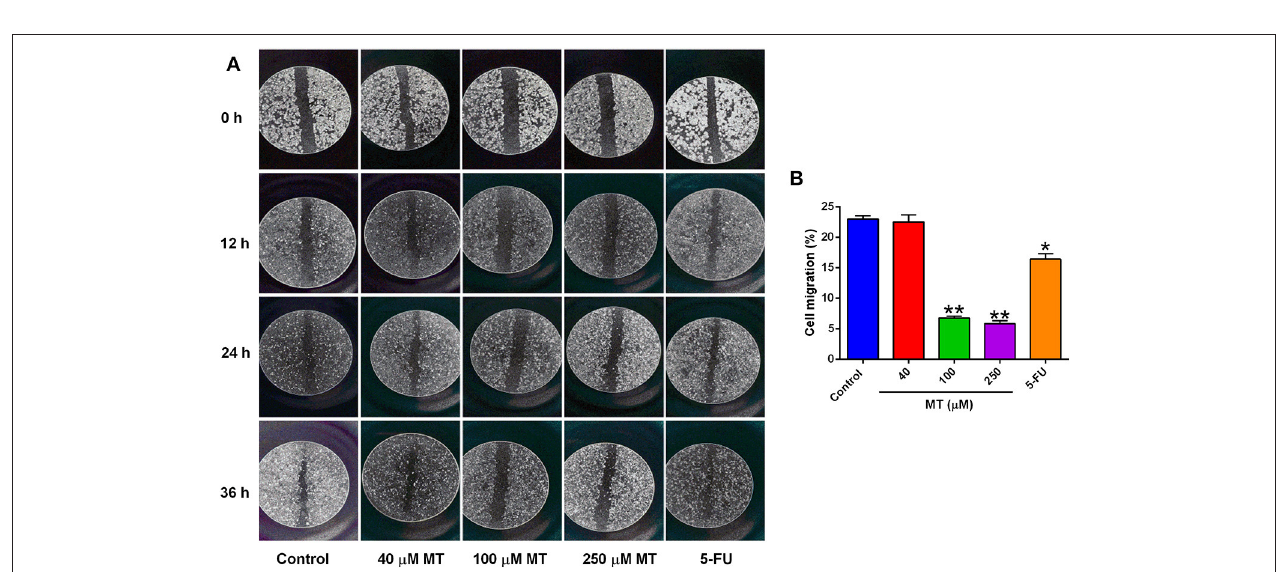
FIGURE 3 | Effects of MT on HepG2 cell migration was determined by wound-healing test. (A) Representative images (at a magnification of 5 × ) of the wound healing of HepG2 cells after different drug treatments. (B) Quantification of cell migration of HepG2 cells after different treatments. Data from at least three independent experiments performed in triplicates are presented; * P < 0.05 and ** P < 0.01 compared to the corresponding control